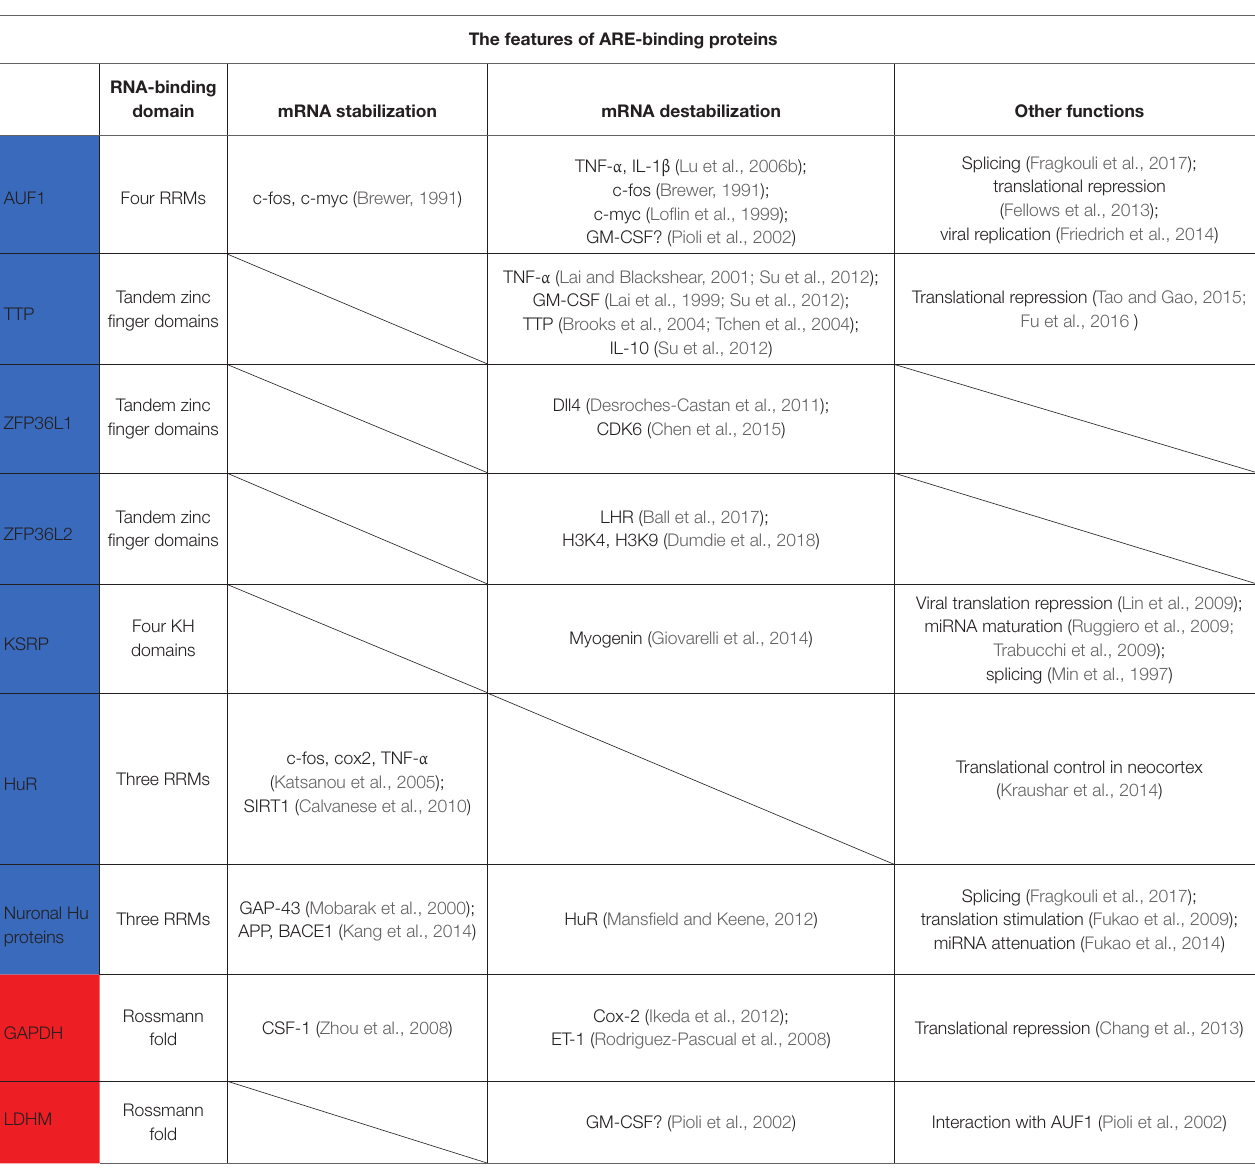
TABLE 1 | The RBDs, targets, and functions of ARE-BPs in this